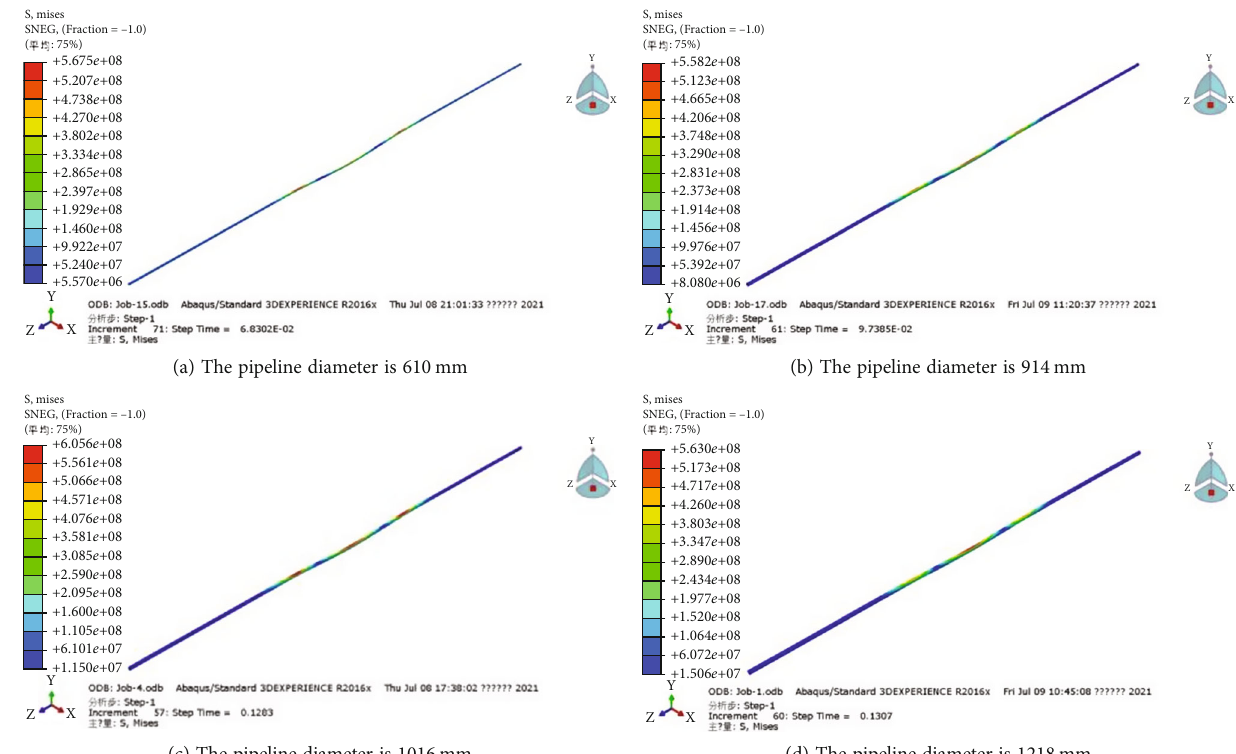
Figure 21: The pipeline stress under di ff erent pipeline